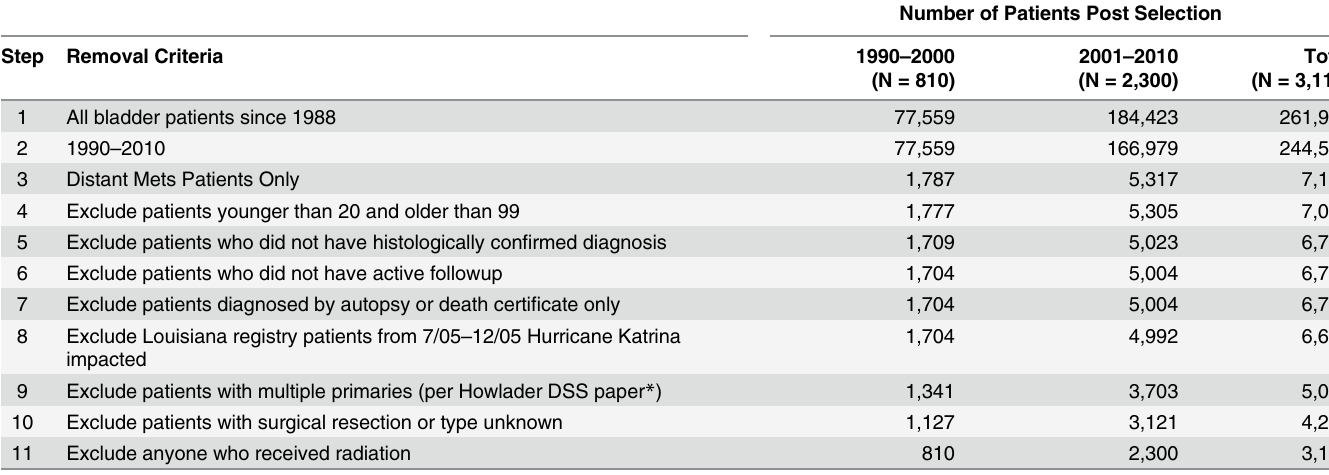
Table 1. Stepwise inclusion and exclusion of patients with urothelial carcinoma included in the SEER database from 1990 – 2010.